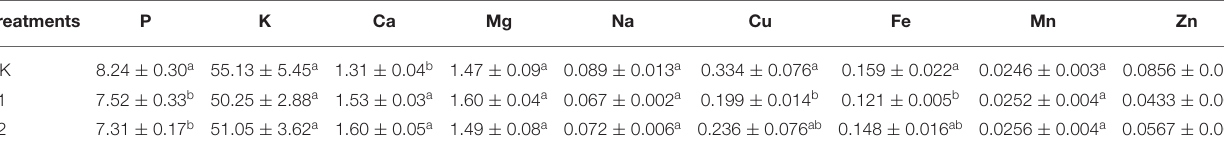
TABLE 1 | Mineral contents in tomato fruits under different LED supplementary light periods (mg/g).